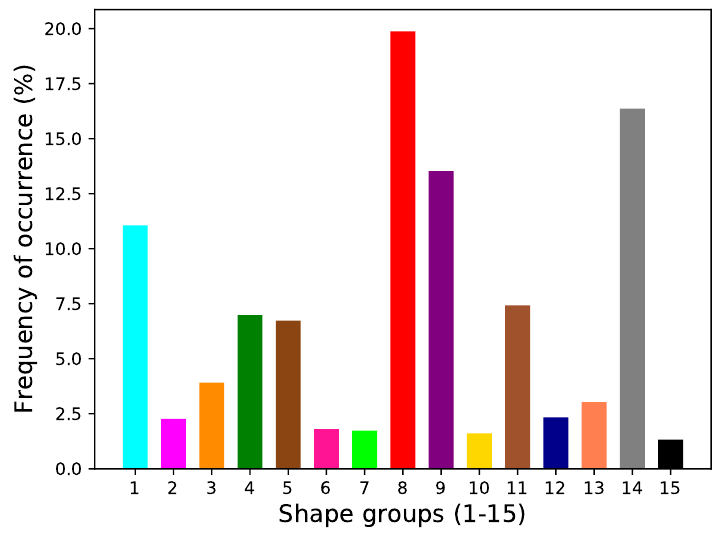
Figure 3. Occurrence of shape groups